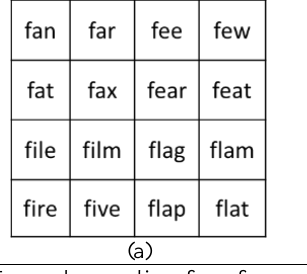
Algorithm 1: Forward geocoding, from four-words code to position An array of string data type of four words